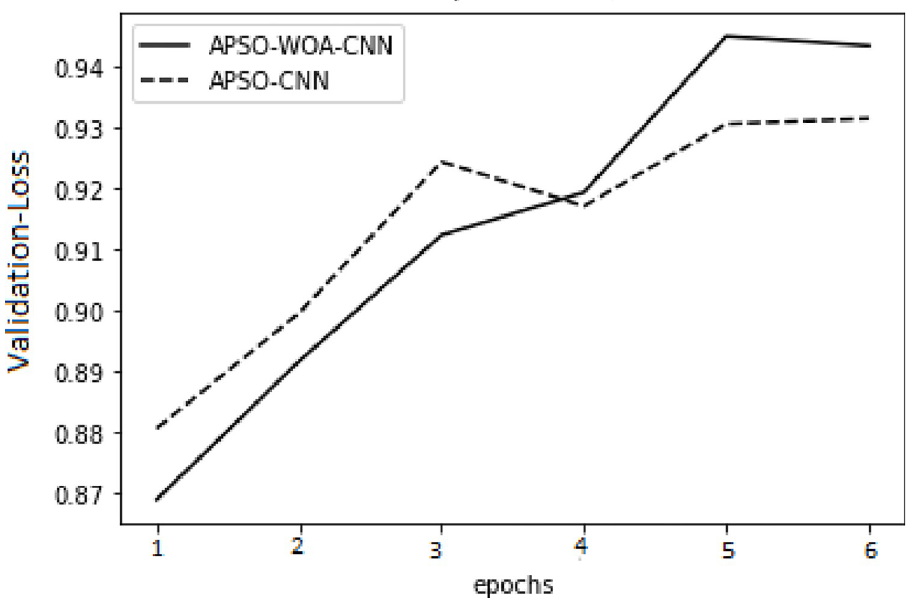
Fig 17. APSO–WOA–CNN and APSO–CNN algorithms’ accuracy validation